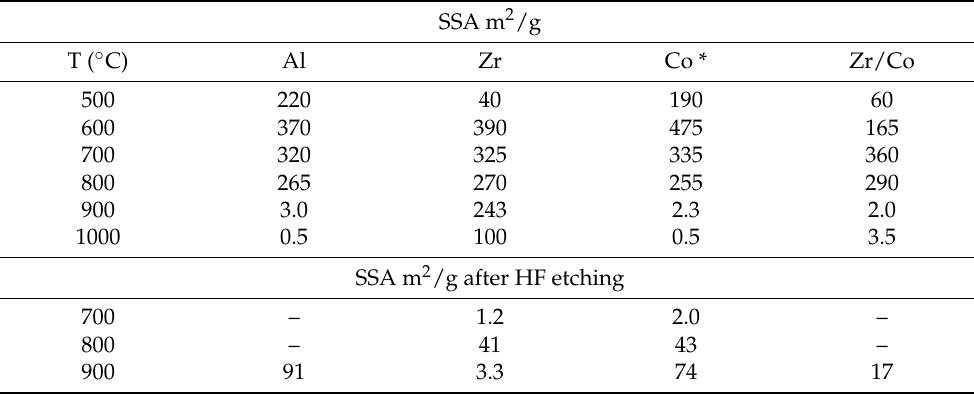
Table 3. Specific surface area of the studied materials as obtained from the BET method applied to the nitrogen adsorption isotherms (the asterisk in Co * refers to already published data reprinted from [44] with permission from Elsevier).